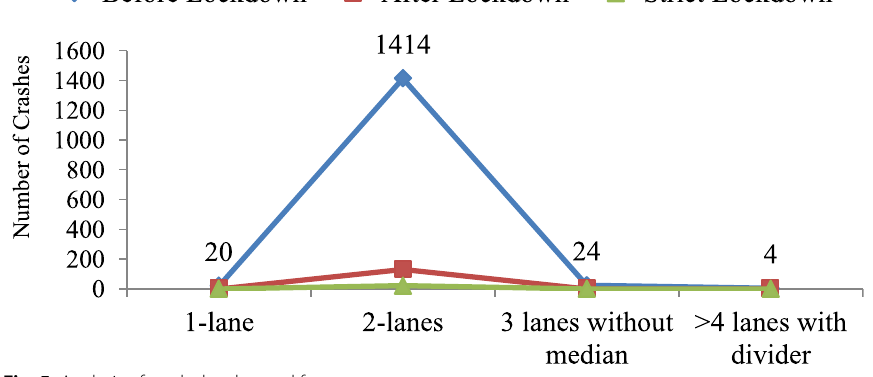
Fig. 5 Analysis of crash data by road feature